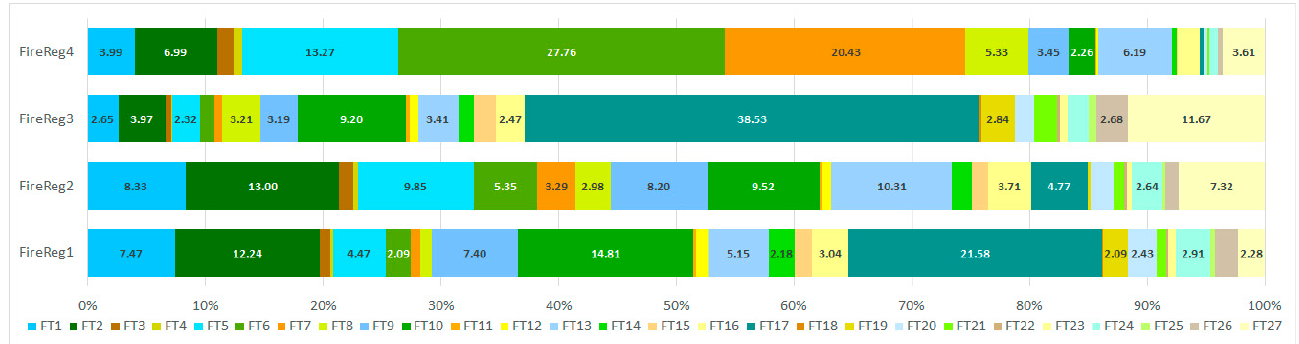
Figure 3. Percentage of each fuel type (FT) that comprise each Fire Regime (FireReg). Numbers indicate the percentage of each fuel type for each fire regime. FTs with no percentage indicated have values < 2%.